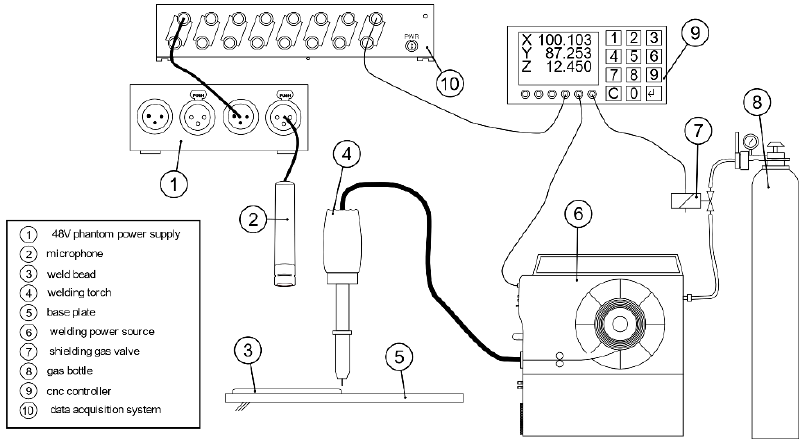
Figure 1. Experimental setup for welding experiments.